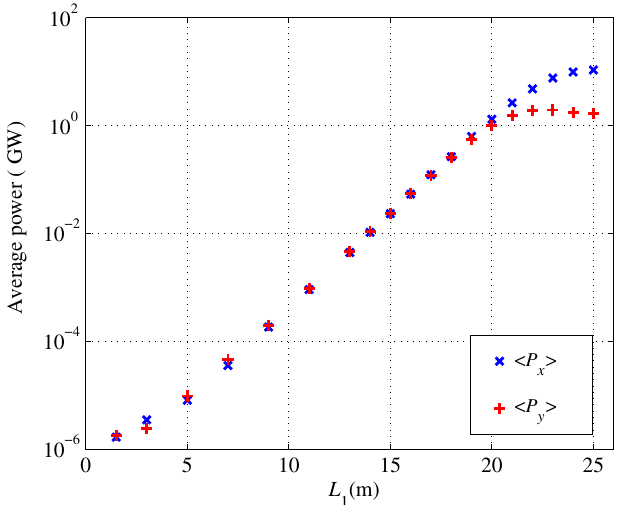
FIG. 2. (Color) 1D simulations of the average SASE power at 1.5 nm from the first (blue cross) and the second (red plus) is the length of the first undulator, L undulator. Here L 1 (cid:4) 1 : 53 m is the length of the second 1 : 3 L G